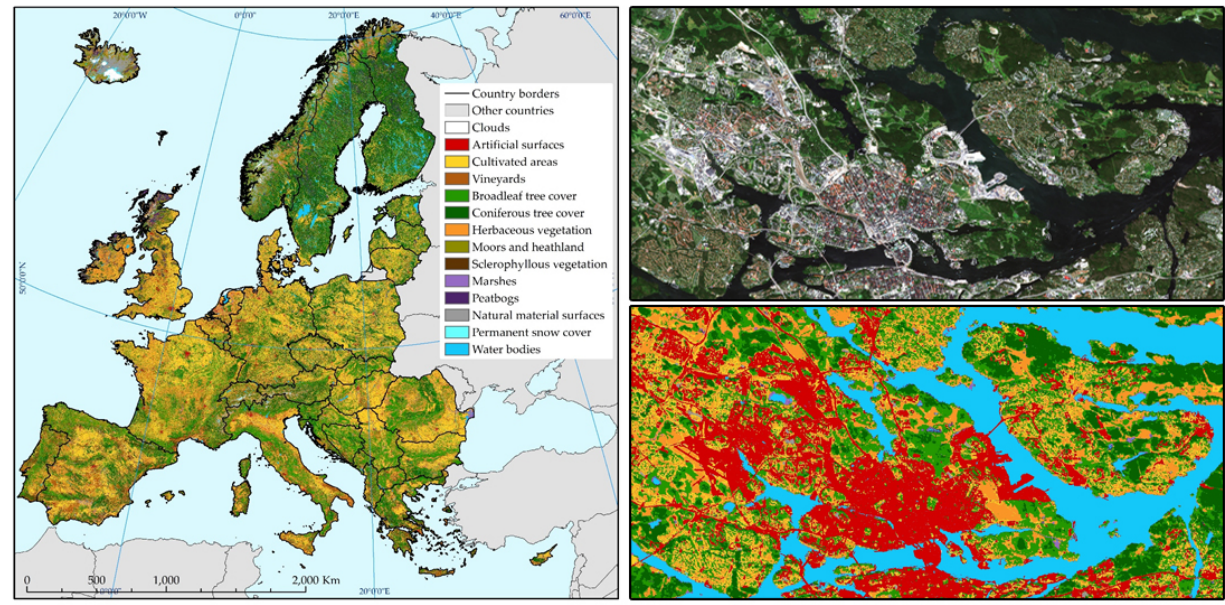
Figure 1. S2GLC 2017—Land Cover Map of Europe 2017. Source: